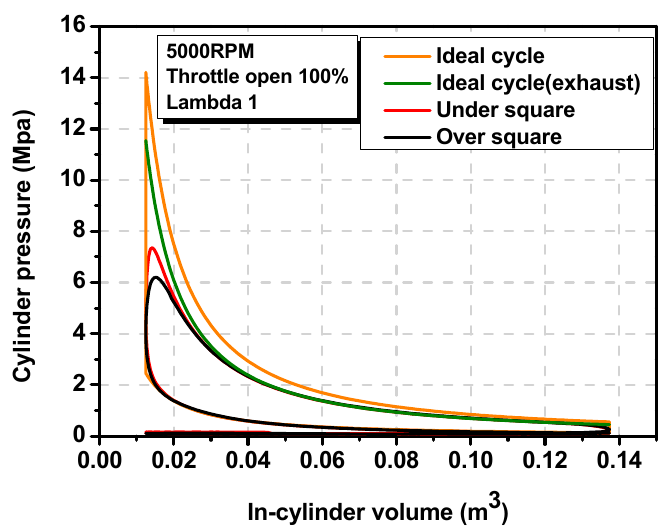
Figure 5. The P–V diagram for over- and under-square engines compared to the ideal cycle .